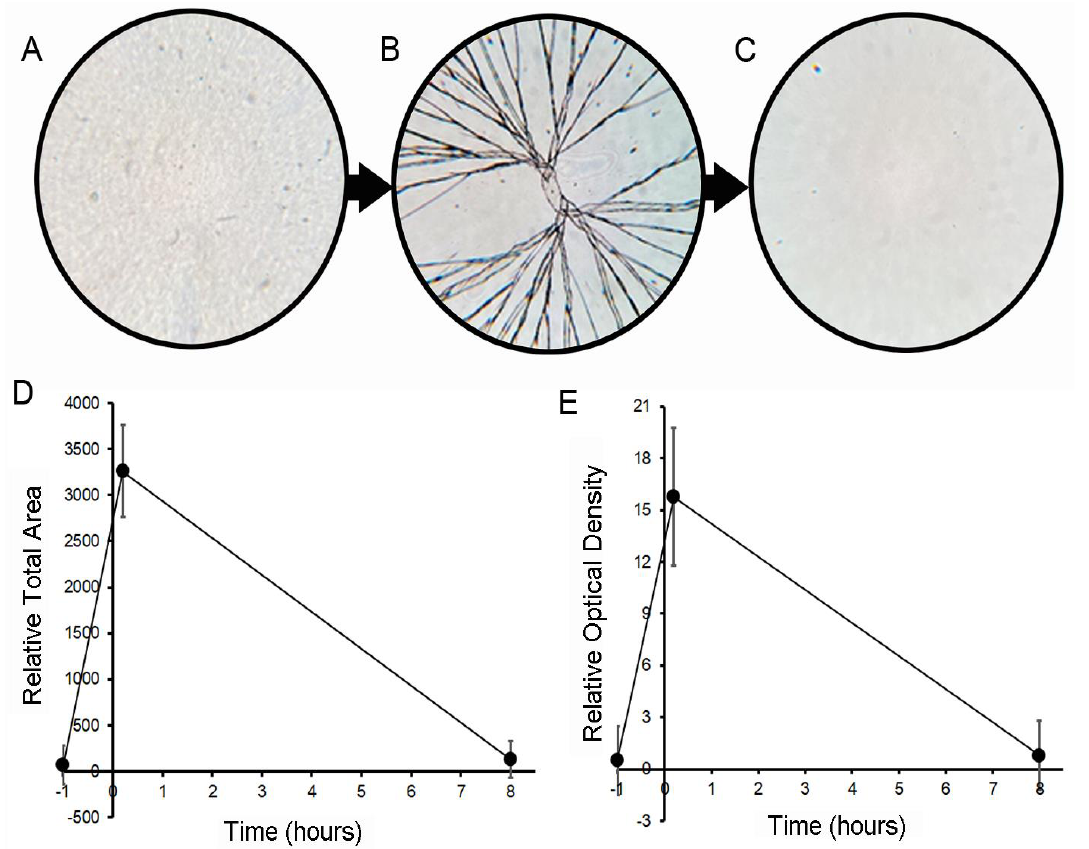
Figure 3. Optical properties of pectin films after fracture and water-induced repair. ( A ) A representative film was fractured ( B ) using a controlled uniaxial load with a 5 mm stainless steel probe (2 mm/sec) and then underwent water repair ( C ). Epi-illumination light microscopy was used to image the films. After routine thresholding and processing with standard MetaMorph filters, the optical features were measured using MetaMorph ’ s integrated morphometry applications. Morphometric assessment of Relative Total Area ( D ) and Relative Optical Density ( E ) are dimensionless functions that indicated near-complete resolution of the fracture-associated optical defects after the eight-hour repair period. The mean + 1 standard deviation (SD) of the replicate samples (N = 8) is shown. The optical properties were assessed at a water content of 8% ( w / w ).